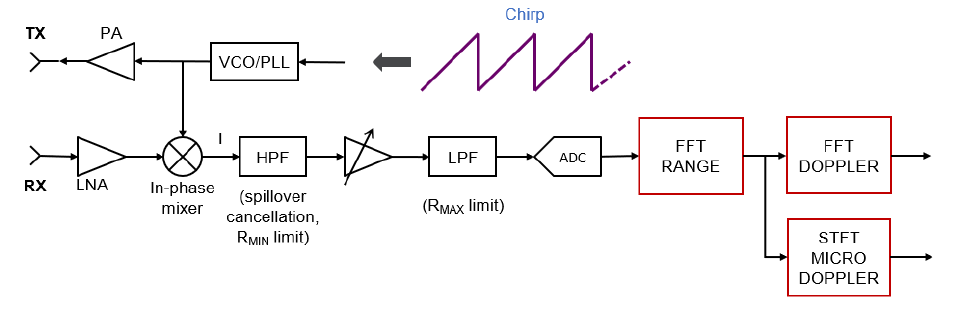
Figure 2. Radar block diagram: basic FMCW radar system with one transmitter and one receiver, depicting the typical linear sawtooth waveform and data processing modules after the ADC block.